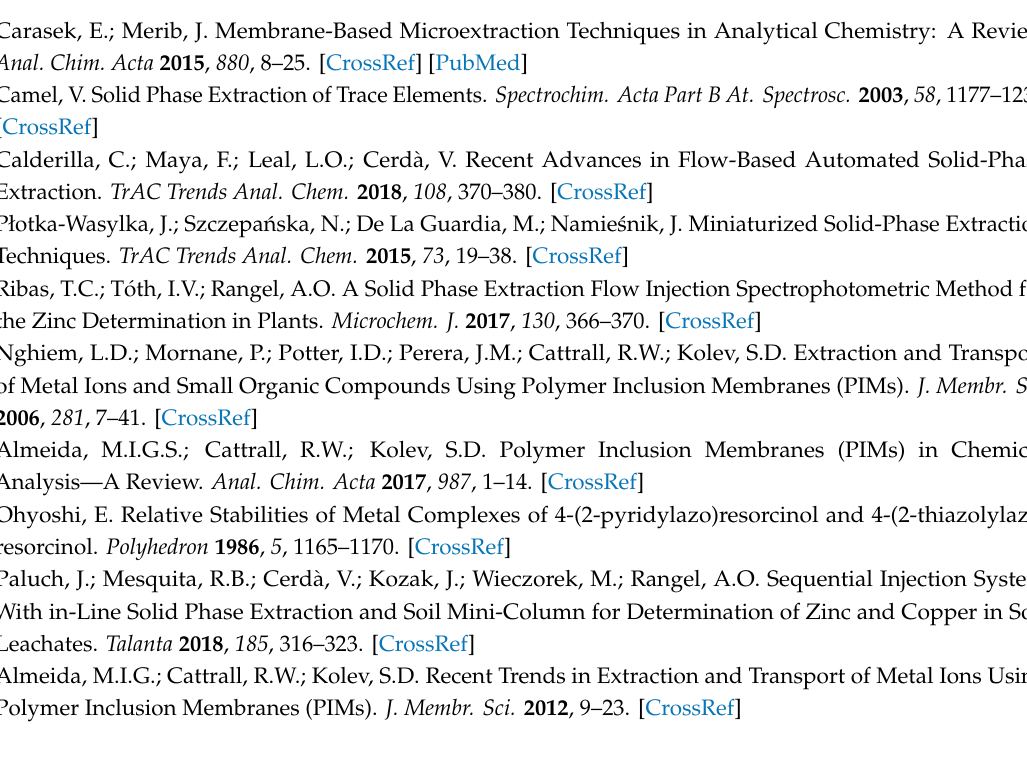
Supplementary Materials: The following are available online. Figure S1: Spectra of the colour metal complexes with PAR (A) and PAN (B); spectra of the blank (reagent in milliQ water) (blue lines), Cu(II)-PAR / PAN complex (yellow lines) and Zn(II)-PAR / PAN complex (green lines); PAR / PAN concentration of 0.1 mmol L − 1 ; metal ion concentration of 0.5 µ g L − 1 ; and carbonate bu ff er (0.6 mmol L − 1 ) solution at pH = 10, Figure S2: Study of the e ff ect of the PIM column (A) and the Chelex column (B) on the calibration curves of zinc(II) and copper(II): (A) direct zinc(II) calibration curve without (blue) and with (orange) using a PIM; and (B) calibration curve with mixed standards of copper(II) and zinc(II) aspirated through the Chelex column (green) and without going through the Chelex column (grey) and calibration curve with zinc(II) standards with (yellow) and without (blue) using a Chelex column, Figure S3: Comparison of the results obtained with the newly developed SIA system and those obtained with a reference method (ICP-OES): (A) copper(II) determination; and (B) zinc(II) determination. The lines represent the linear relationship between the two